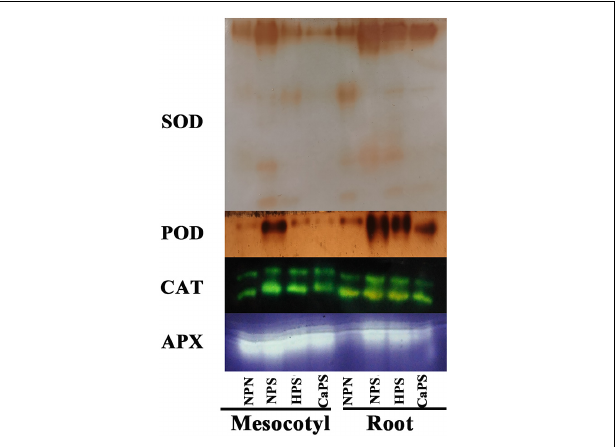
FIGURE 8 | Staining of antioxidant enzymes in mesocotyl and